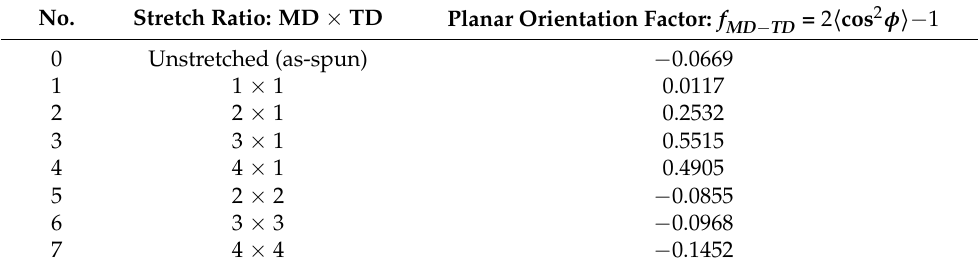
Figure 3. Orientation distribution of fibers in ( a ) the as-spun PET web and ( b ) the web after annealing (MD × TD = 1 × 1). The annealed webs after planar stretching at the stretch ratio of MD × TD = ( c ) 2 × 1, ( d ) 3 × 1, and ( e ) 4 × 1. The annealed webs after simultaneous equibiaxial stretching at the stretch ratio of MD × TD = ( f ) 2 × 2, ( g ) 3 × 3, and ( h ) 4 × 4. Table 2. Fiber orientation factor in the webs.